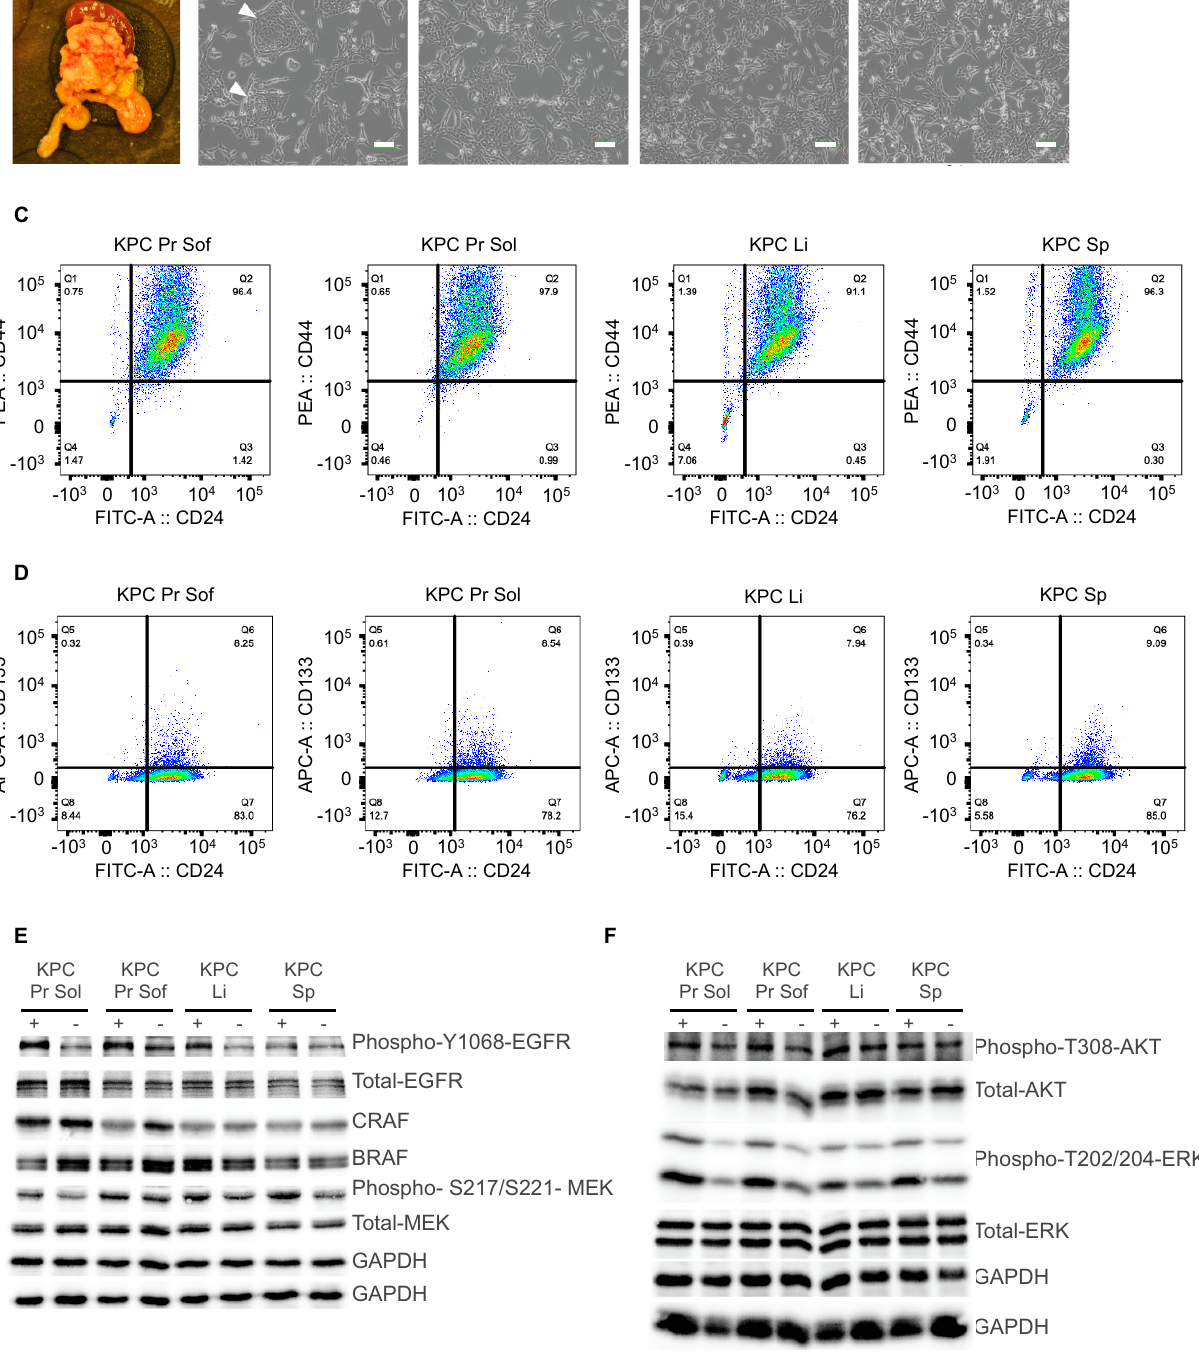
Figure 2. Establishing a Kras G12D -driven mouse model of metastatic PDAC. ( A ). Picture of primary tumor and spleen from which the cell lines were generated. ( B ). Representative images of primary cells four passages after isolation. White arrows indicate epithelial islands which were detectable only in the KPC Pr Sof cell line. Scale bars = 100 μ m. ( C , D ). Flow cytometry analysis of CD44, CD24 and CD133 expression in pancreatic primary tumor and metastatic cell lines. 50,000 cells per cell line were analyzed. CD44 versus CD24 expression is shown after gates were set on the negative control ( C ) or on the single-stained CD24 control ( D ). ( E , F ). Protein immunoblotting for the indicated antibodies on cells isolated from primary KPC tumors (Pr Sof and Pr Sol) and metastatic lesions from liver (Li) and spleen (Sp) with or without a 5-min stimulation with EGF (10 ng/ μ L)prior to protein isolation. GAPDH blotting represented a loading control on the replicate blots used in this figure. Samples were run on replicate blots that were probed with different antibodies. Two different GAPDH loading control blots were therefore conducted.